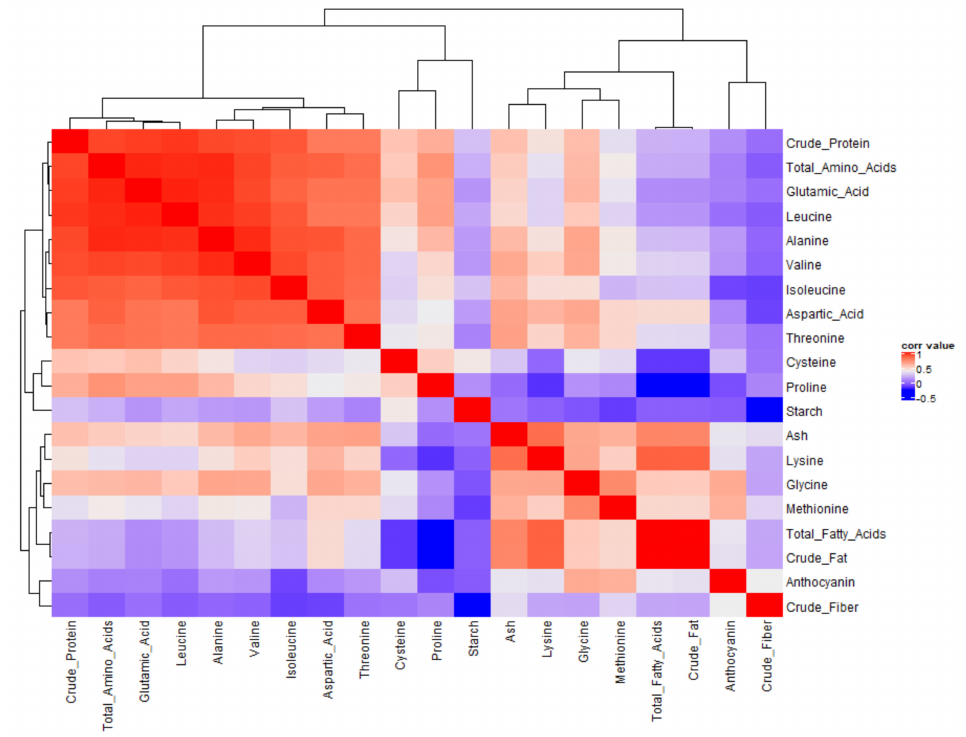
Figure 2. Correlation matrix heat map for di ff erent grain compositional